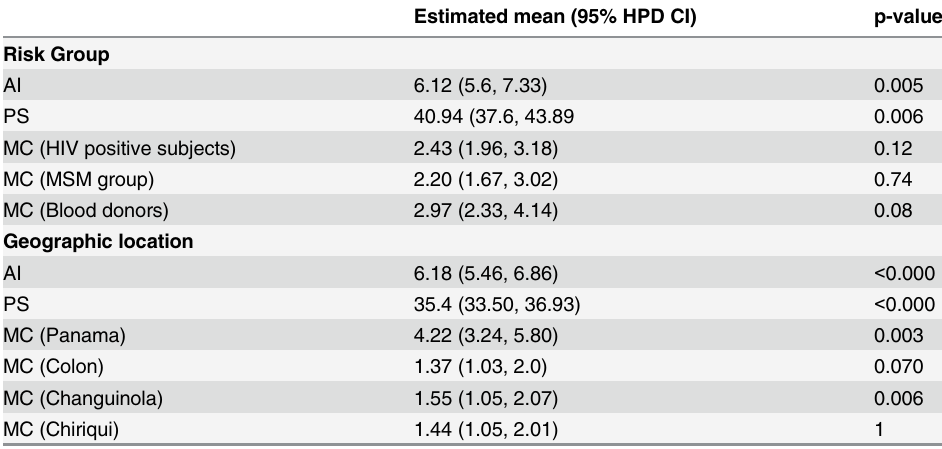
Table 2. Bayesian phylogeny-traits association results, according to risk behavior group and geo- graphic